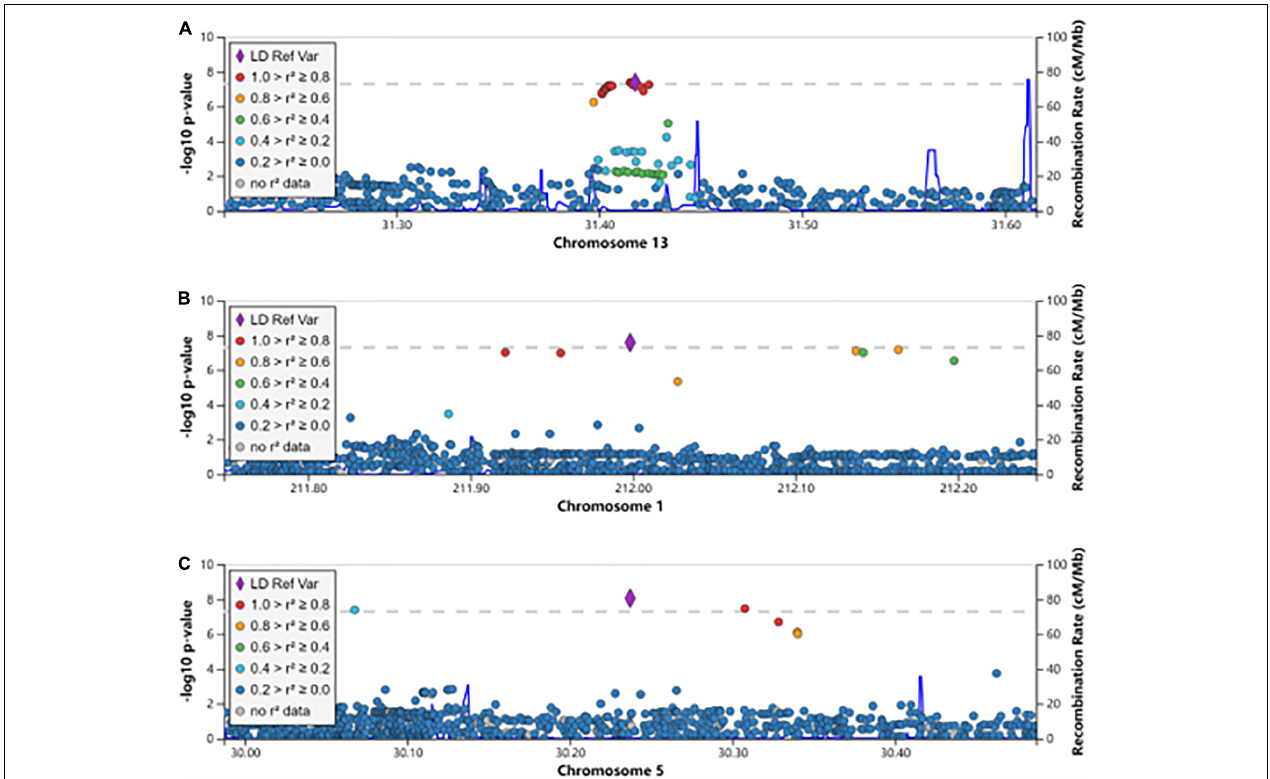
FIGURE 2 | The regional association plots for the novel genome-wide significant loci associated with HBV/HCV infection. The genomic coordination is indicated on the X -axis, and the -log10 P -value of meta-analysis is shown on the left Y -axis. The most significantly associated SNP is shown in purple, and the different colors represent the linkage disequilibrium between the surrounding SNPs and the lead SNP. (A) The locus 13q12.3; (B) the locus 1q32.3; and (C) the locus 5p13.3.